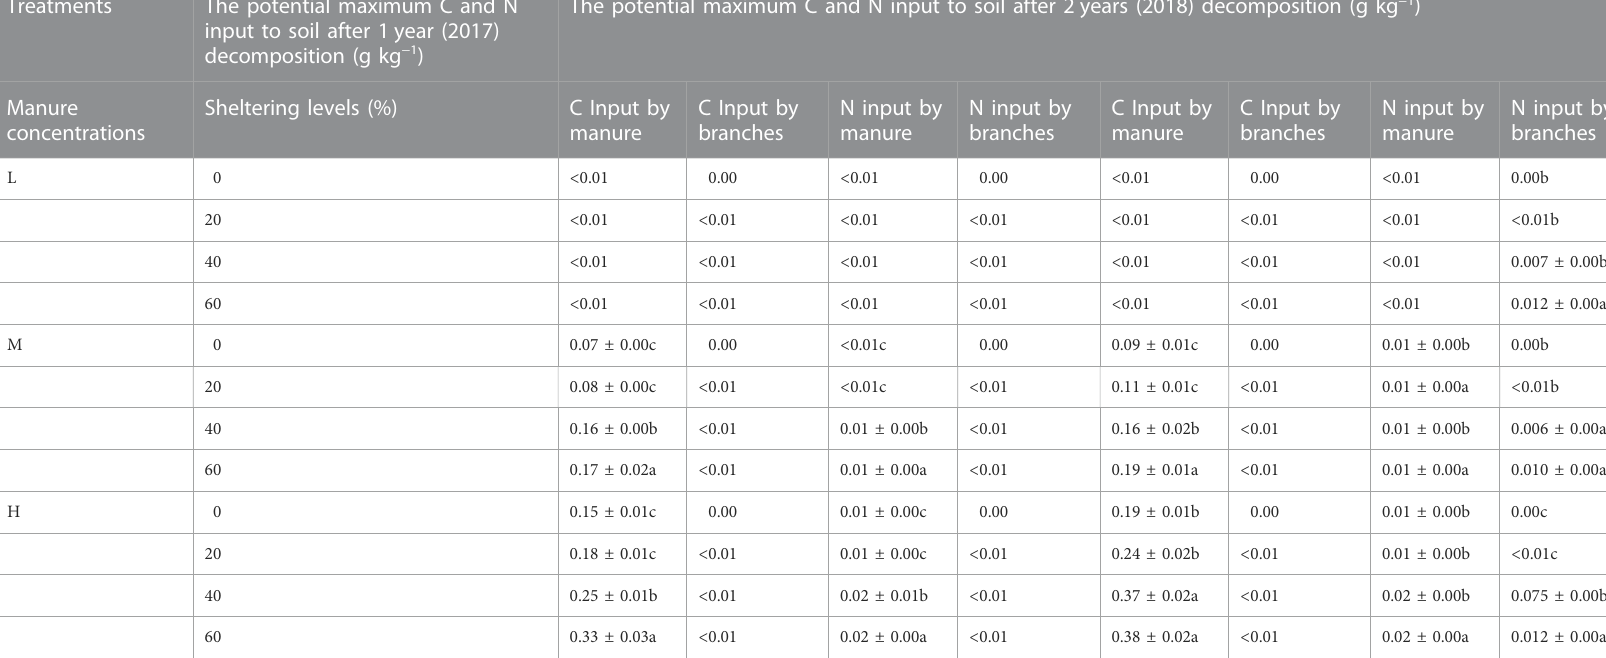
Different letters following means indicate signi fi cant differences among different sheltering levels at 0.05 level (p <